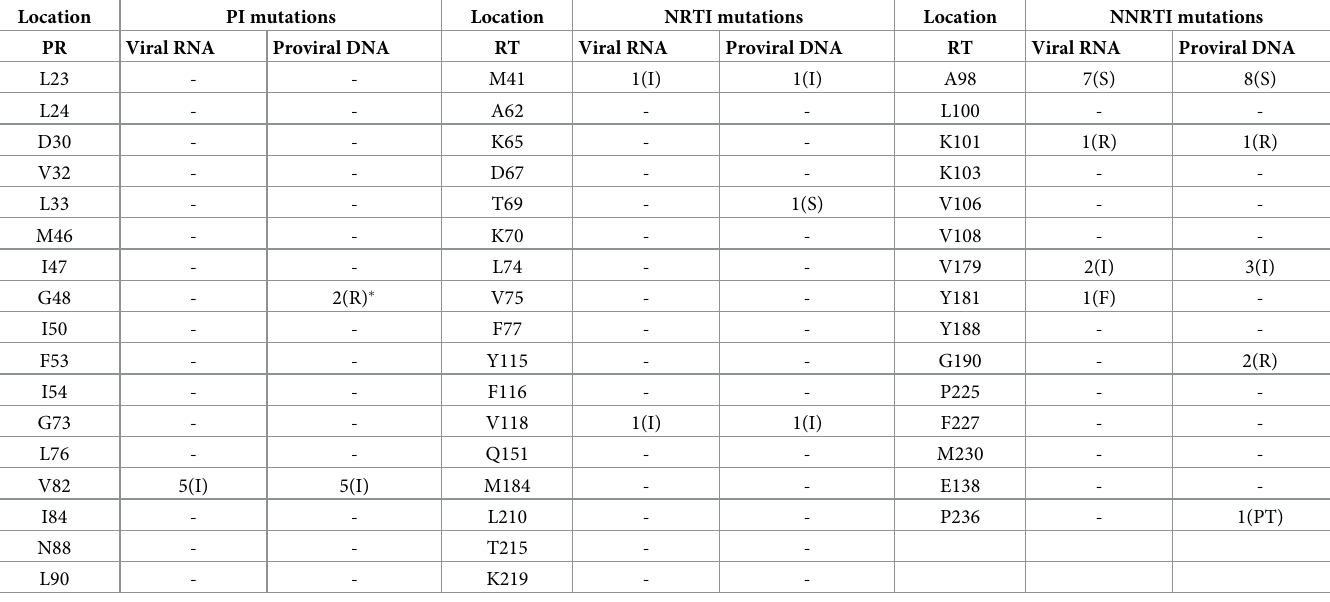
Table 5. Frequency of polymorphisms at drug resistance positions in HIV viral RNA and proviral DNA in treatment naïve patients.